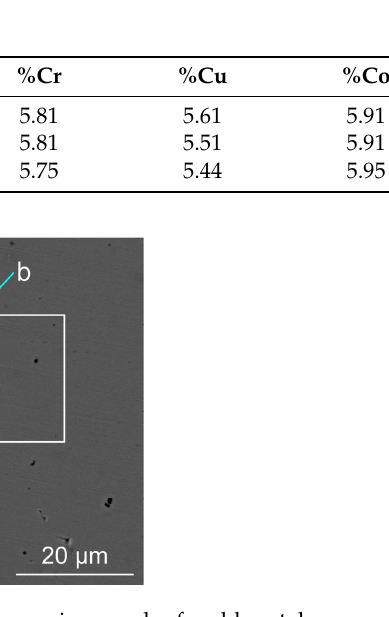
Figure 2. Scanning electron microscope micrograph of weld metal areas, marked a, b, and c (see Table 2 for the analyses per marked phase areas a, b, and c) (×3290).